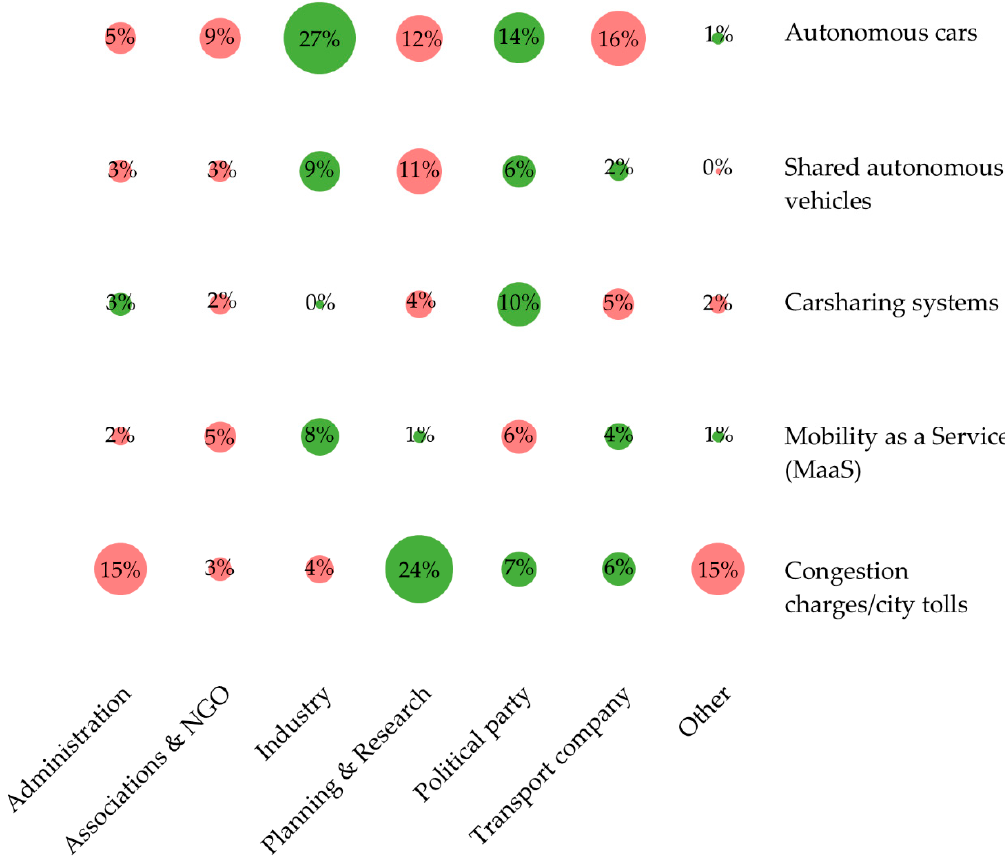
Figure 3. Difference in the openness of stakeholders compared to the mean value regarding technological innovations. Red, below average; green, above average. Data: ZHAW, Aalto University, tbw research.